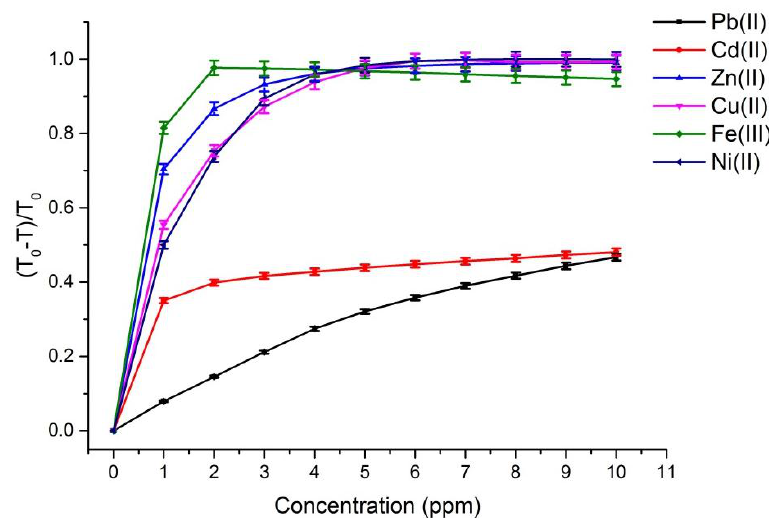
Figure 3. The response curves obtained from the transmittance spectra at 525 nm which were achieved with a portable colorimetric system based in a multispectral sensor for different metallic ions at different concentrations. The measurements were repeated ten times and the fluctuations of each experimental point were about 0.1%. The error bars were calculated considering the error in the photocurrent measurement of the multispectral sensor 1.7% (in the worst case).